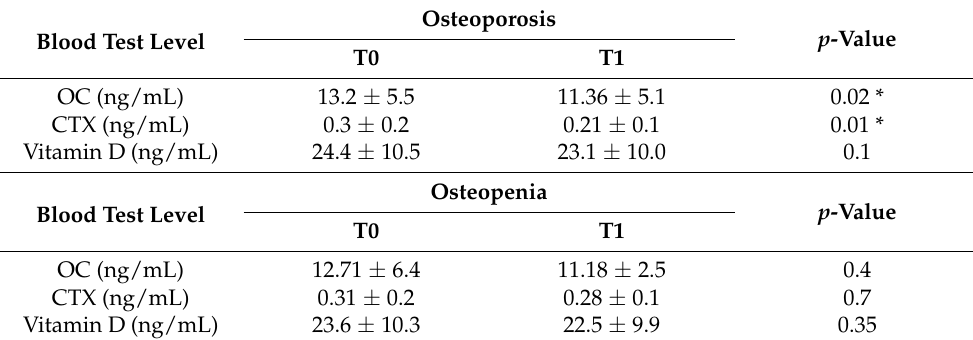
Table 4. Comparison of changes in laboratory finding after 12 months in each